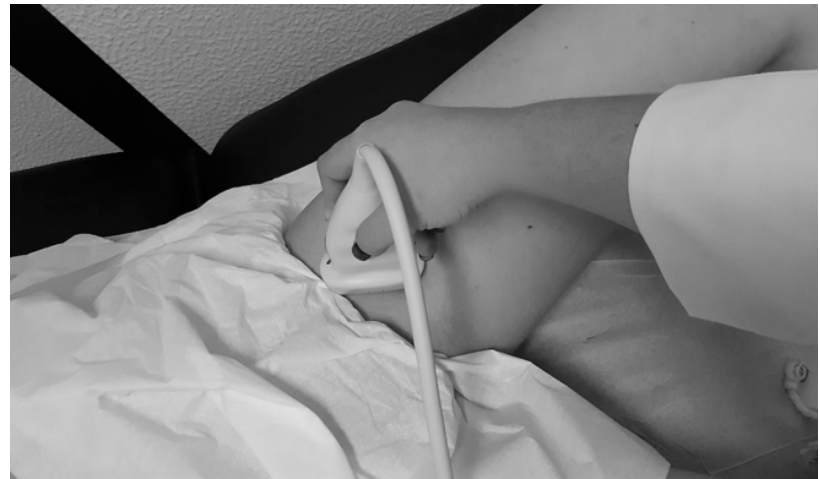
Figure 1. Transducer in position for doppler echo study in the proximal segment of the superficial femoral artery of the left lower limb.